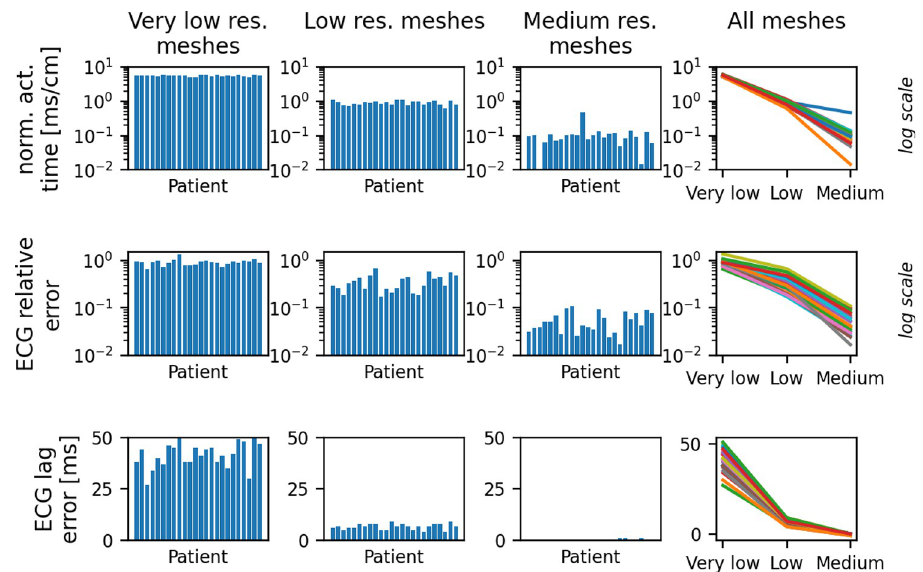
Fig 4. Discretization errors (defined as the difference between very low/low/medium results and the high-resolution results), for each patient, in normalized apex-to-base activation time (top row) and simulated ECG (middle and bottom rows). Note: Log scale used for top and middle rows. ECG lag errors (bottom row) take integer values, and since most results are exactly zero for the medium resolution meshes, a log scale is not used for ECG lag.